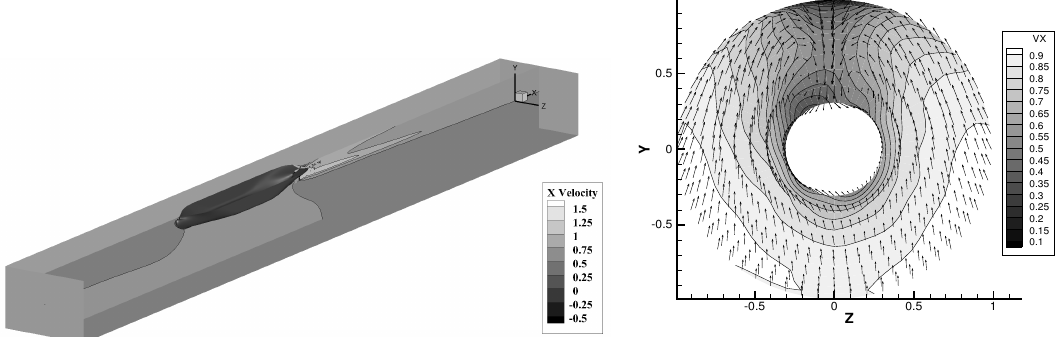
Figure 25. Computational domain of RANS model in the BEM/RANS coupling method ( left ). Non-axisymmetric effective wake predicted by the same method at J S = 0.7758 ( right ). The effective wake is evaluated on the mid-chord disk; therefore, the actual effective wake may vary in the axial direction. Axial component is represented by contour plot, and the in-plane velocities are presented by